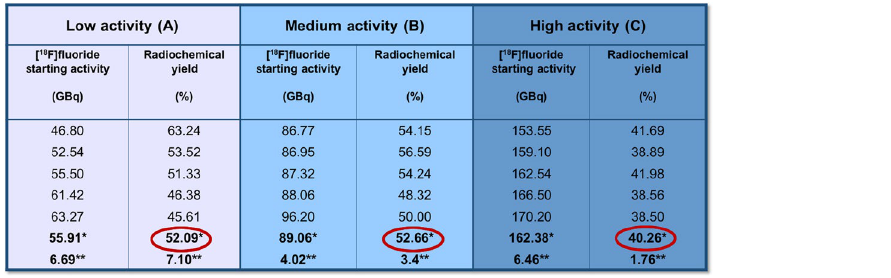
RCY average values (%) estimated at EOS, not corrected for decay and related to a synthesis time of ≃ 40 ′ . For activities A and B, RCY score is 52%, for activity C it decreases to